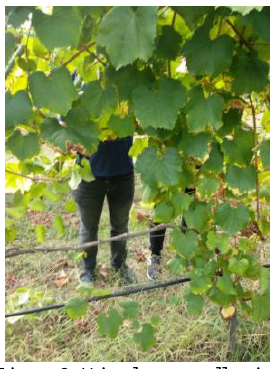
Figure 2. Vine leaves collection